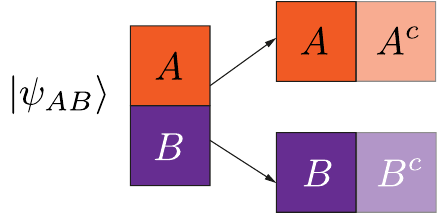
Fig. 13 Illustration of mutual complexity. We start by a pure state on a system AB which is then split into two mixed states on the systems A and B . The sum of the complexities of purification of these mixed states using ancillary systems A c and B c is not necessarily equal to the complexity of the original pure